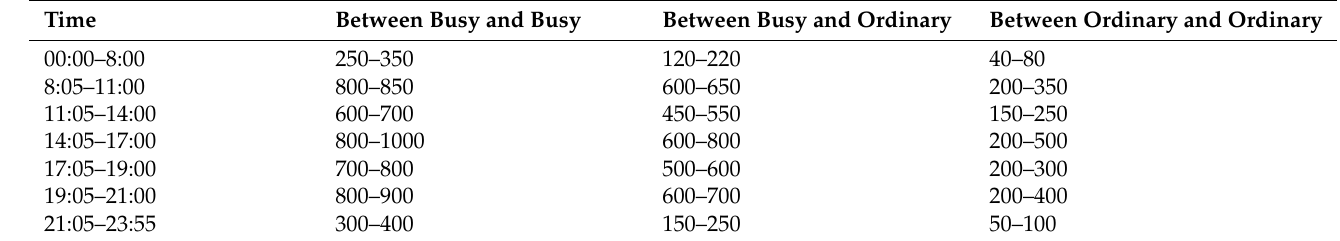
Table 5. Network traffic between different